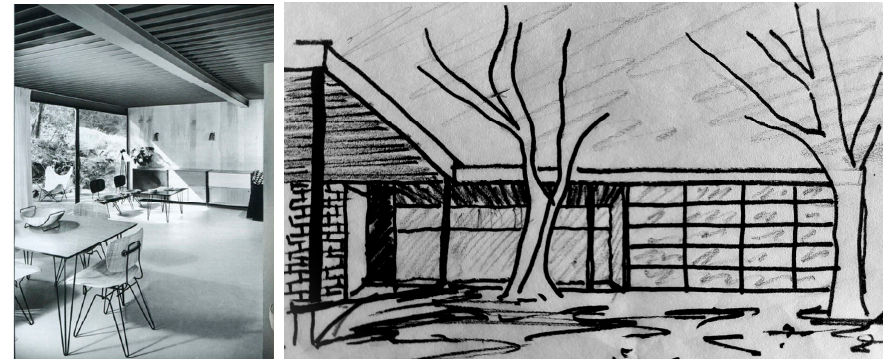
Figure 8. House Koenig #1, Los Encinos Avenue, Glendale, Califórnia, 1950 [15].